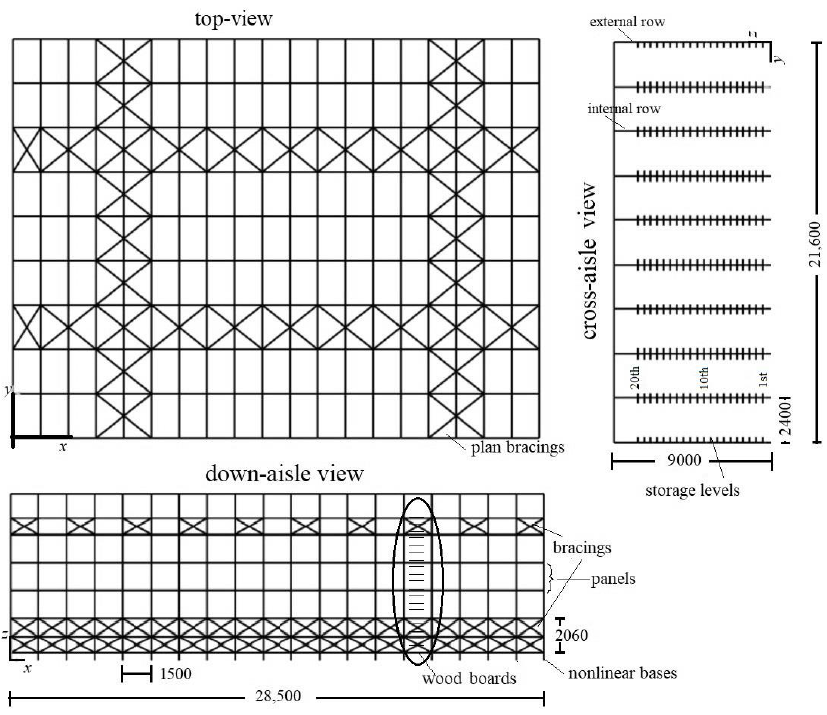
Figure 6. Peculiarities of the considered rack model (dimensions in millimeters). Buildings 2020 , 10 , x FOR PEER REVIEW